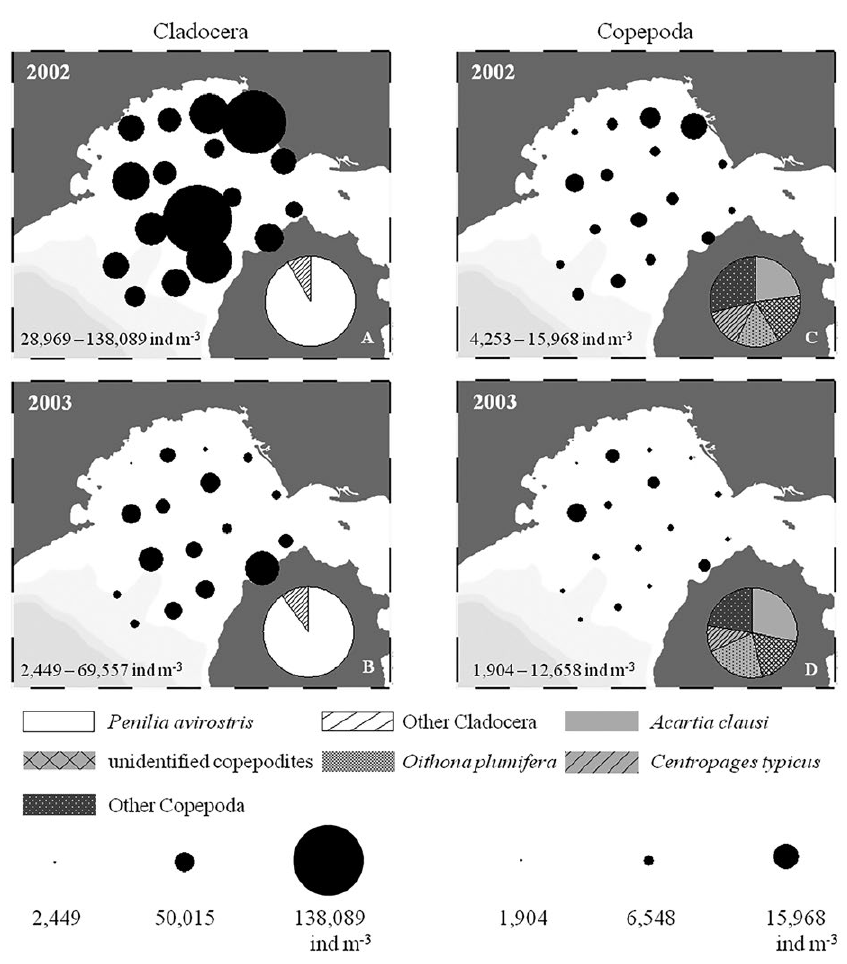
Fig. 3. – Abundance of Cladocera (A and B) and Copepoda (C and D) community in Kavala Gulf during 2002 (A and C) and 2003 (B and D). Discs are proportional to abundance. Values for smaller and larger disc (range of abundance values) are indicated. In the right corner of each graph the average between the sampling stations’ contribution of dominant taxa in the community of Cladocera (A and C) and Copepoda (B and D) is plotted in a pie